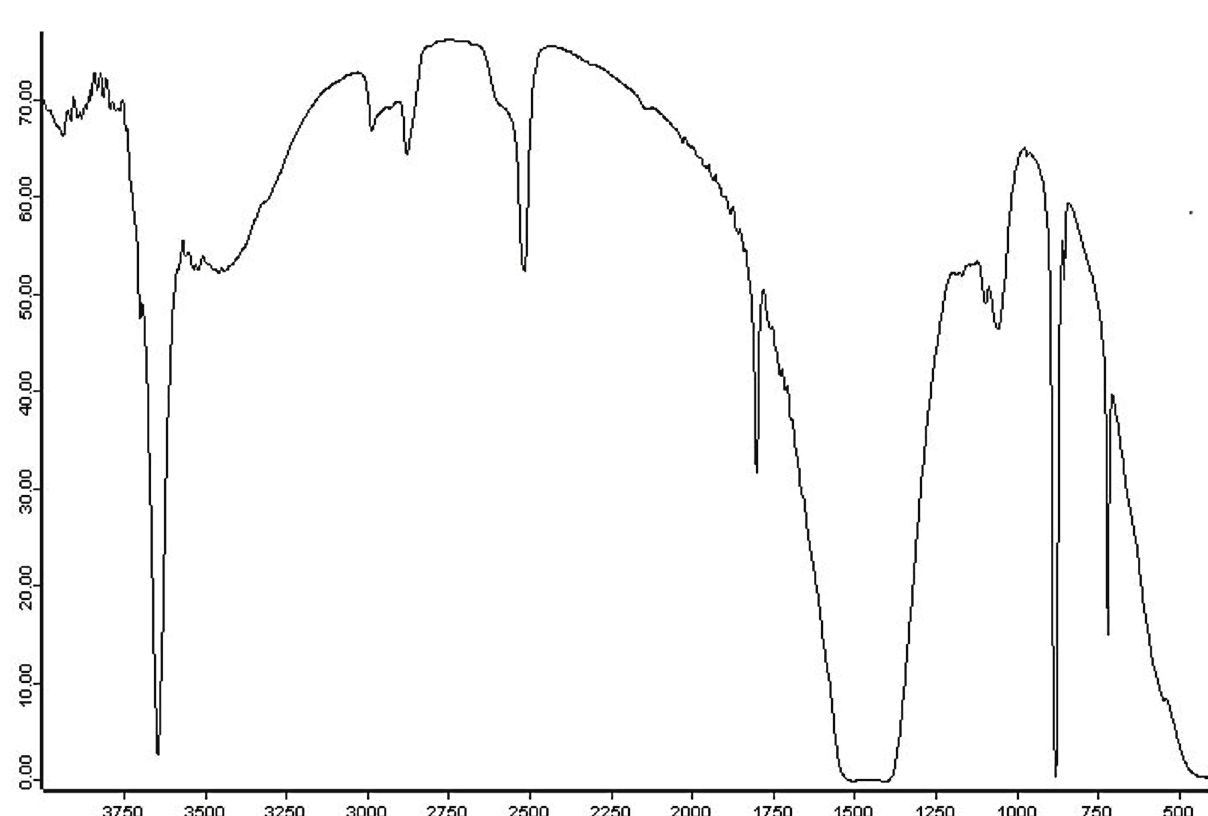
Fig. 2 – IR spectrum of CES